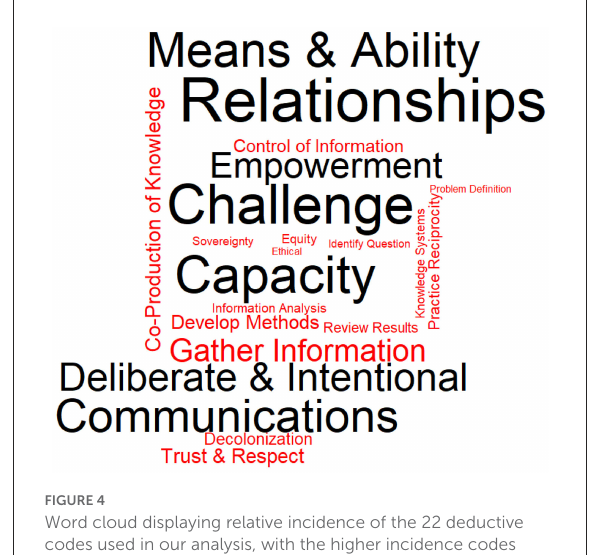
FIGURE4 Word cloud displaying relative incidence of the 22 deductive codes used in our analysis, with the higher incidence codes displaying larger and lower incidence codes displaying smaller, with size dependent on absolute incidence of each code. Colors do not display any categorical difference between codes and were chosen to match colors in Figure 7. Created by M. Rhodes-Reese in Adobe Illustrator, using NVivo software